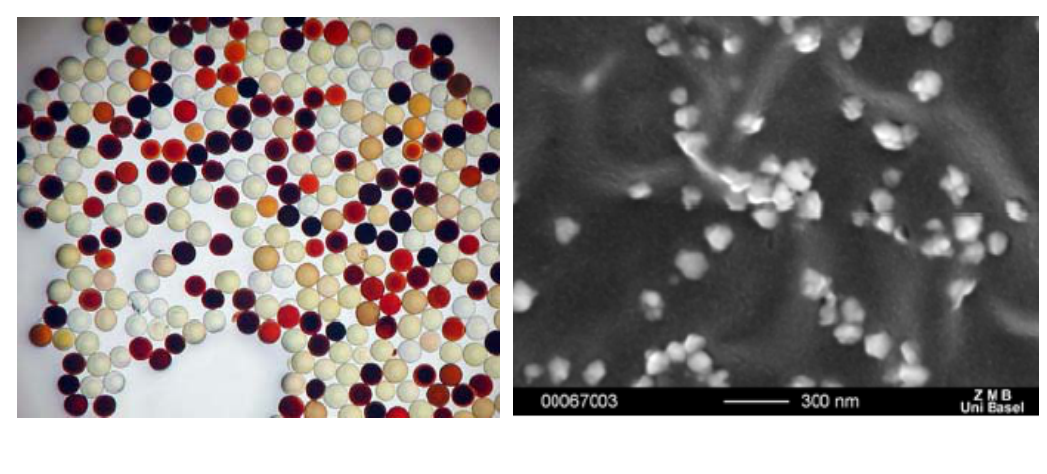
Figure 22. Styrene beads loaded with silver nanoparticles as a function of the amino acid sequence (left) and SEM of nanoparticles on red beads